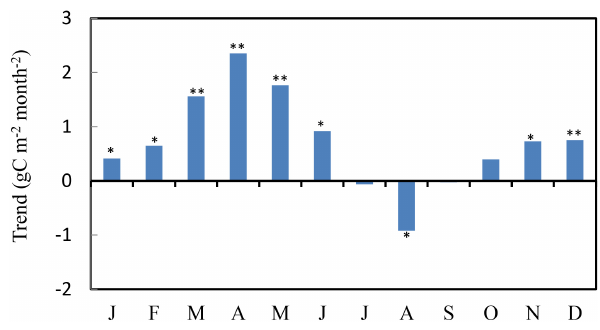
Figure 8. Monthly trend of GPP from 1981 to 2013 (significance levels: ∗ is p <0.05; ∗∗ is p